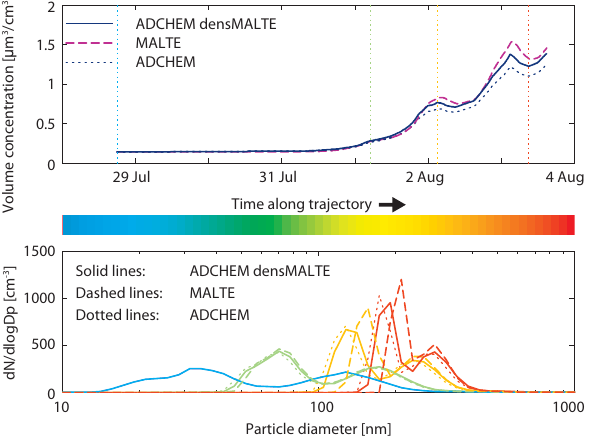
Figure 3. Particle mass concentration along the air-mass trajectory modeled with ADCHEM using different methods of estimating the saturation vapor pressures of the organic oxidation